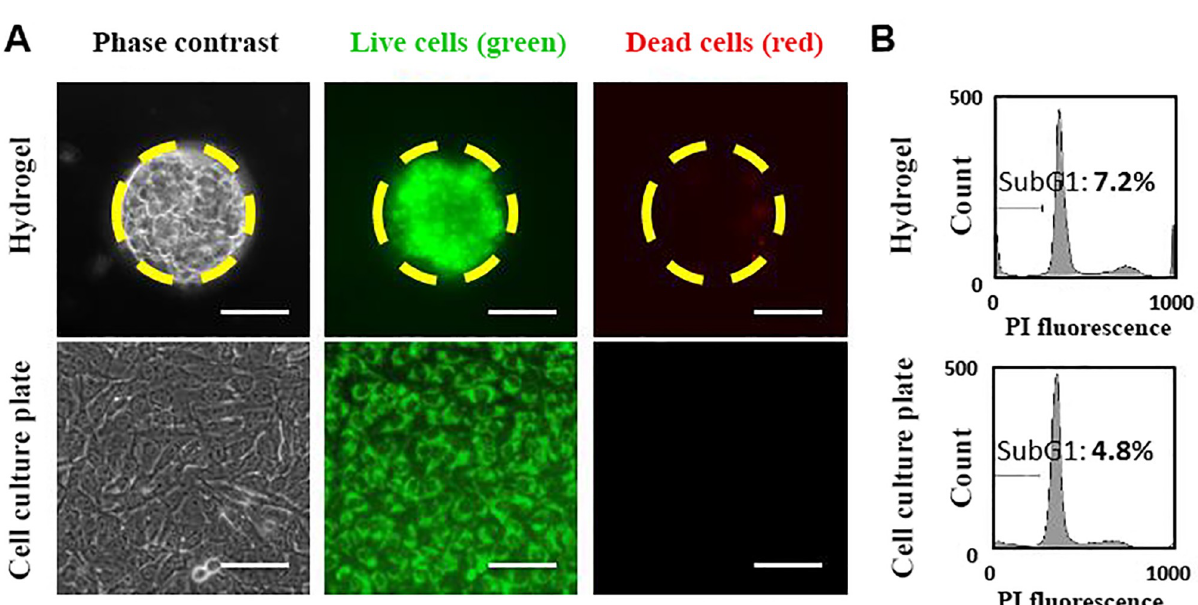
Fig 3. Characterization of U251 cells in spheroid and monolayer cultures. A) Phase contrast and fluorescence images of U251 cells in the form of a spheroid produced in a 150 μ m well (top row) and monolayer (bottom row). Green fluorescence represents the live cells and red fluorescence represents dead cells. Yellow dashed circles mark the border of a single hydrogel microwell. Scale bars represent 80 μ m. B) Sub-G1 population of U251 glioma cells in spheroids (top) and monolayers (bottom).